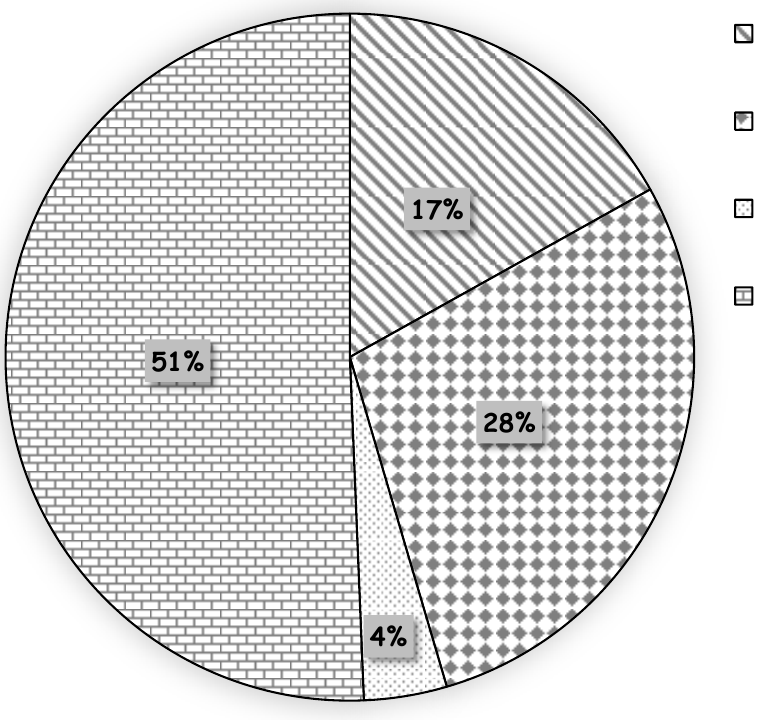
Figure 4. Systematic review by the focus of the study.